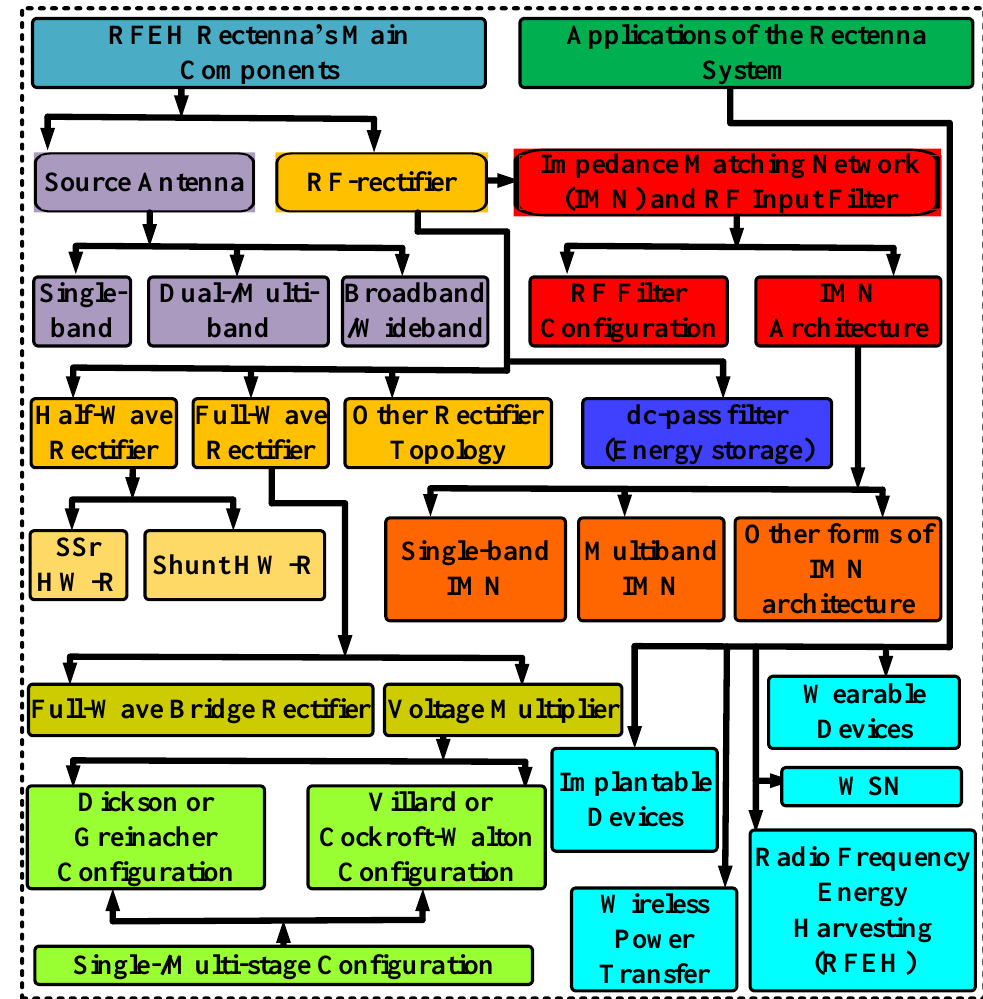
Figure 5. A flow diagram showing several components of the rectenna system